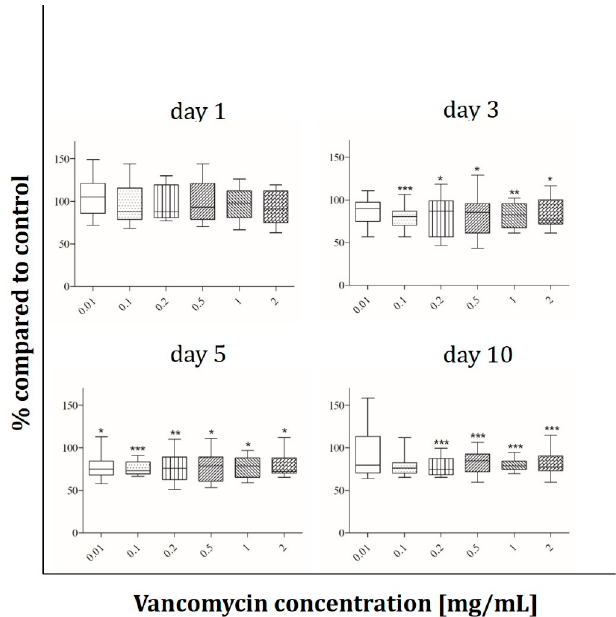
Figure 4. Proliferation of Saos-2 cells after exposure to vancomycin for 1, 3, 5 and 10 days with change of antibiotic every 4 days (* p < 0.05; ** p < 0.01; *** p < 0.001 to control). The results are presented in percentage of the control without vancomycin (100%).